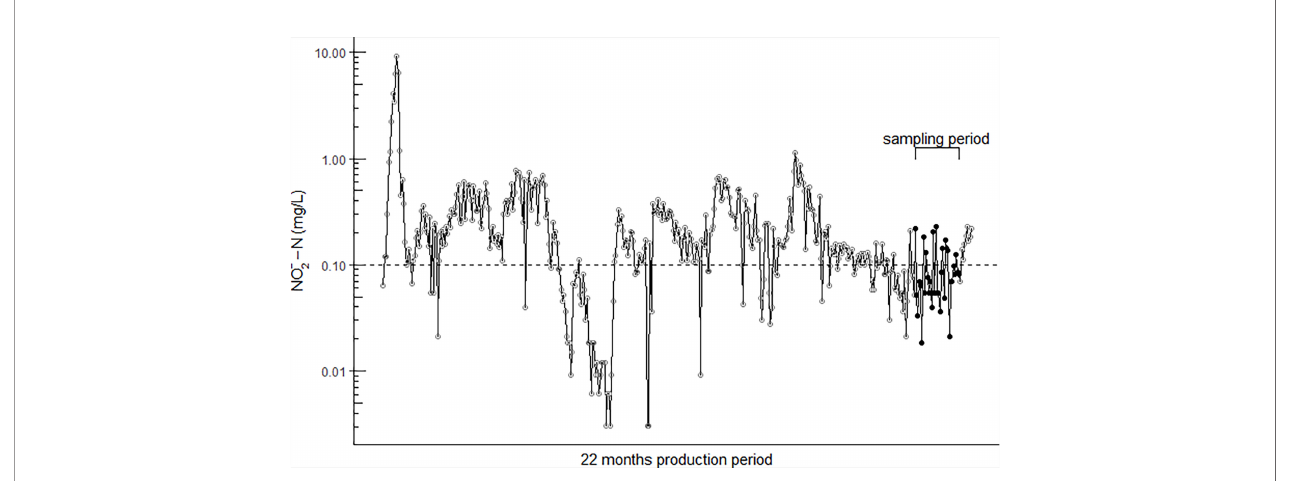
FIGURE 2 | A signi fi cant positive correlation (simple Person´s linear regression) is between the NO − 2 − N and K + concentration in plasma (N=90 fi